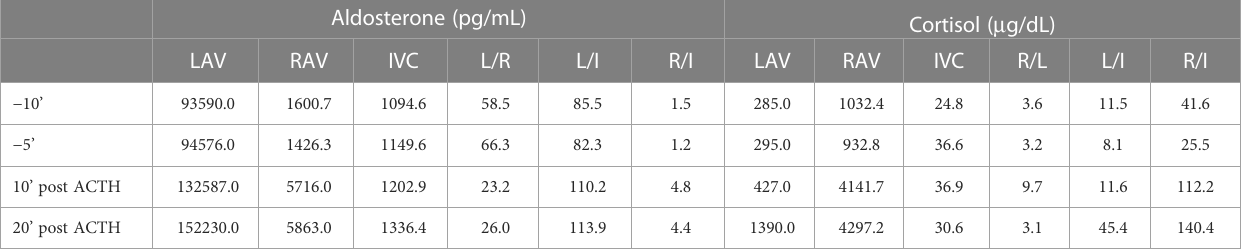
TABLE 2 Results of AVS.